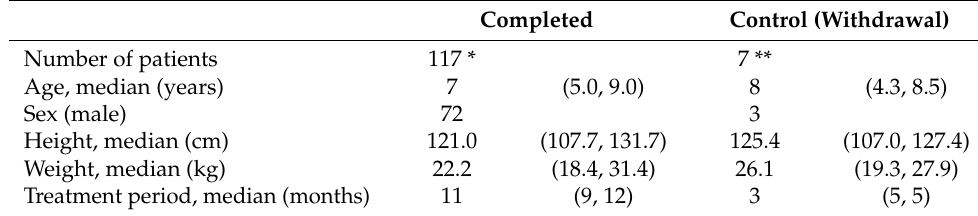
Table 1. Patients’ characteristics.